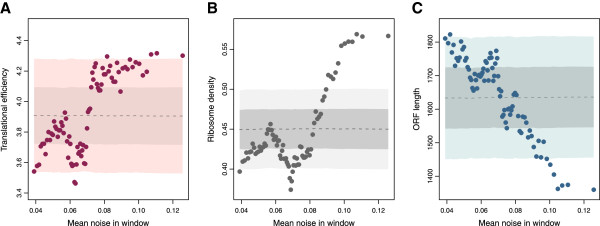
Noise determinants in low plasticity genes. Noise in LP genes is related to translational efficiency, which in turn is related to ORF length. We ordered LP genes by increasing noise. We performed a sliding window analysis of translational efficiency (A), ribosomal density (B) and ORF length (C). Shaded regions represent the mean and two standard deviations at each point obtained with the same sliding window analysis over randomized data; the process was repeated 10000 times. See also main text.